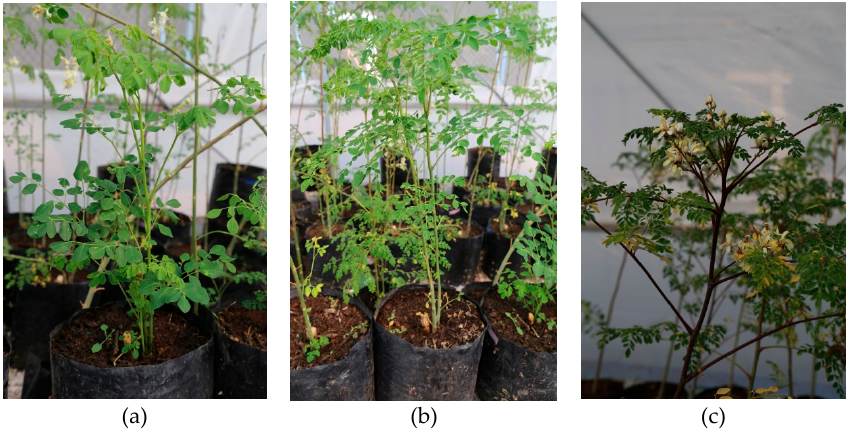
Figure 1. Moringa oleifera plants at different stages of growth: ( a ) at transplant, ( b ) 30 days after transplanting, and ( c ) 60 days after